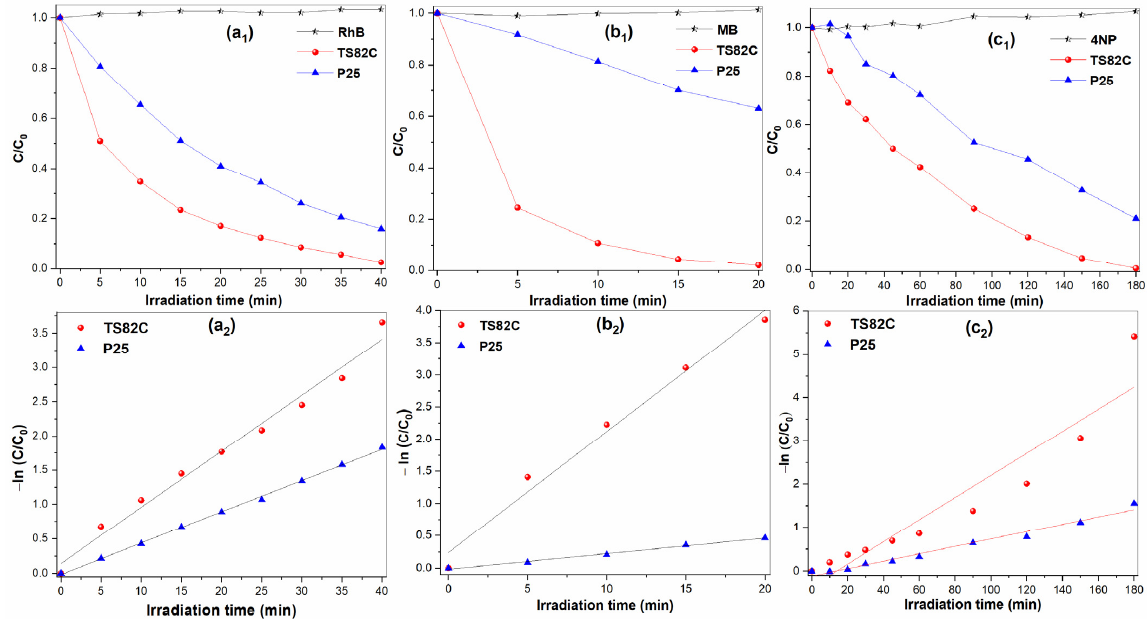
Figure 5. Photo-degradation kinetics of 15 μ M aqueous solution of RhB ( a 1 , a 2 ), MB ( b 1 , b 2 ), and 4NP ( c 1 , c 2 ). Table 3. Kinetic parameters of Rhodamine B, Methylene Blue and 4-Nitrophenol obtained from the photodegradation experiments performed with TS82C and P25 TiO 2 .